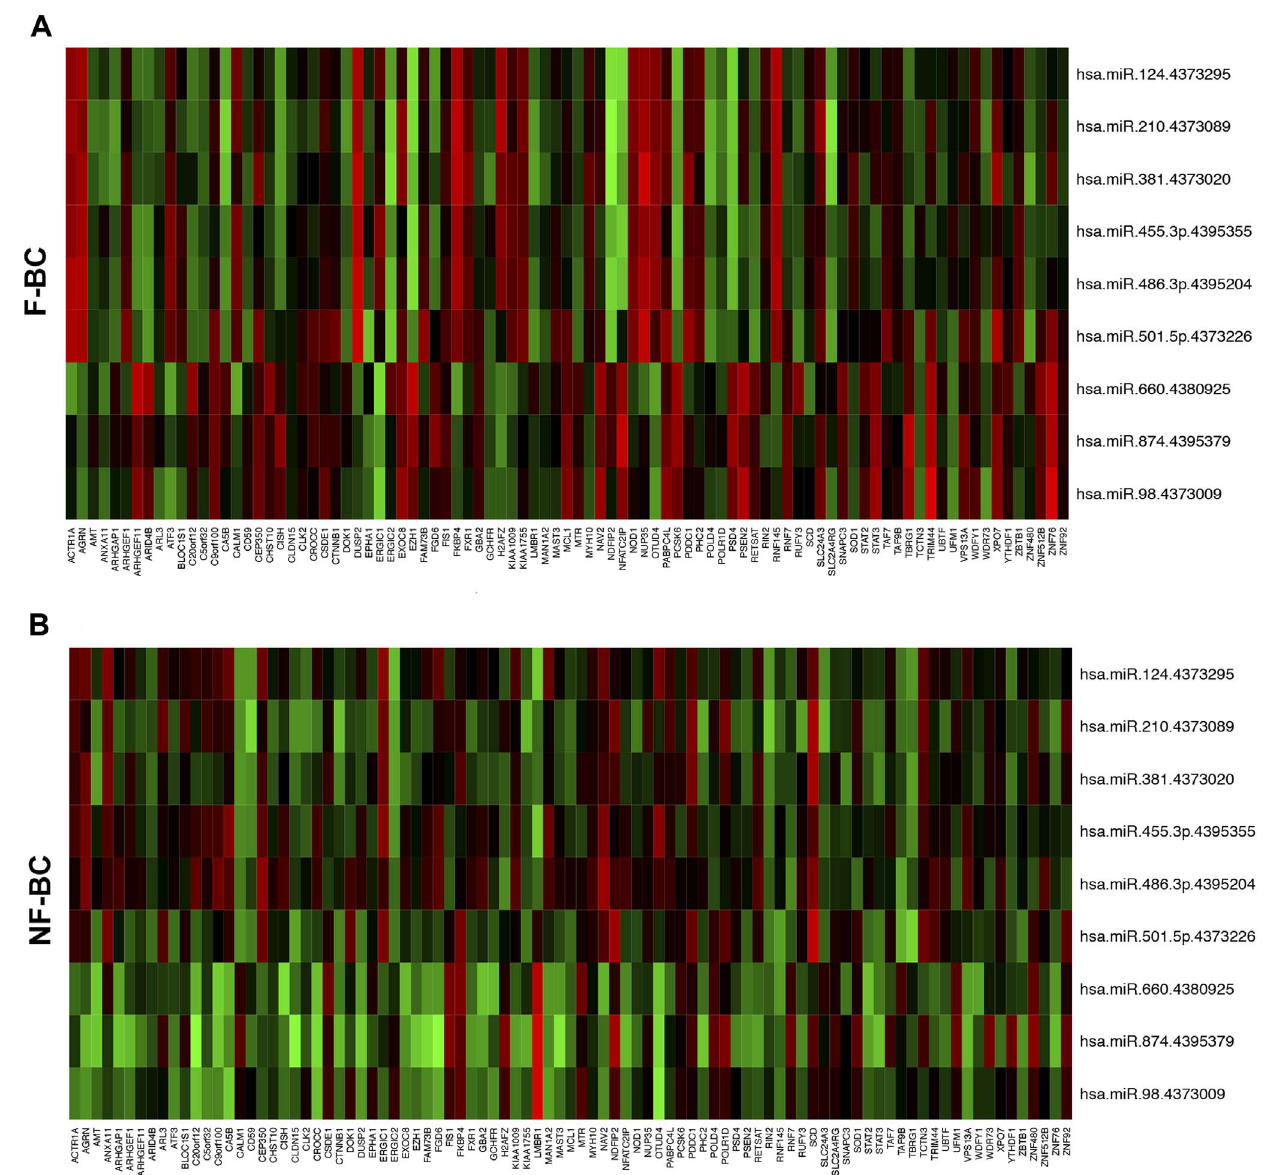
Figure 3. Co-expression matrixes. Co-expression matrixes of the 91 differentially expressed genes vs 9 differentially expressed miRs for F-BC (A) and NF-BC (B), respectively. The colors represent the co-expression values reaching from 1 to 2 1 for red and green, respectively. F-BC, familial breast cancer; NF-BC, non-familial breast cancer.